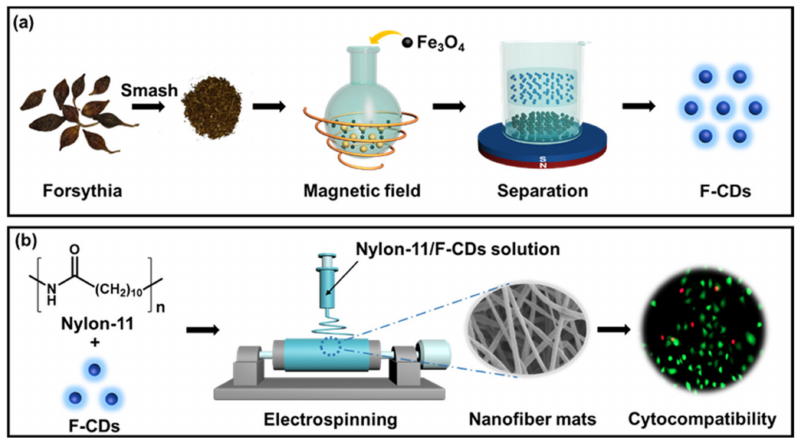
Figure 1. ( a ) Schematic diagram of the operating procedure for the synthesis of F-CDs by the magnetic hyperthermia method. ( b ) Schematic diagram of the preparation of biocompatible nanofiber mats via